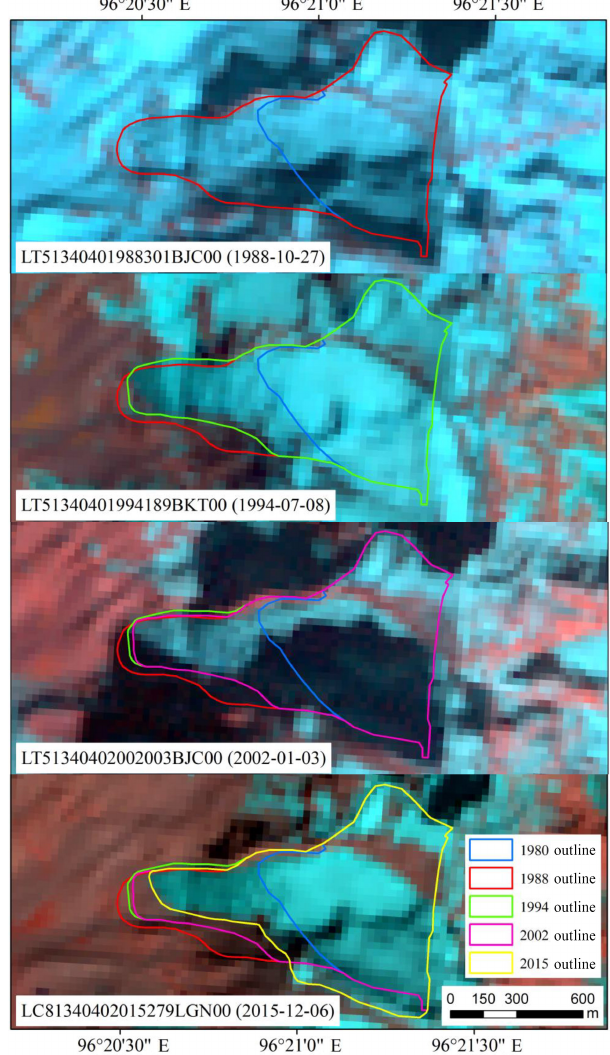
Figure 7. Terminus changes of Glacier 5O282B0111 from 1980 to 2015. Location of the data example is shown in Fig.